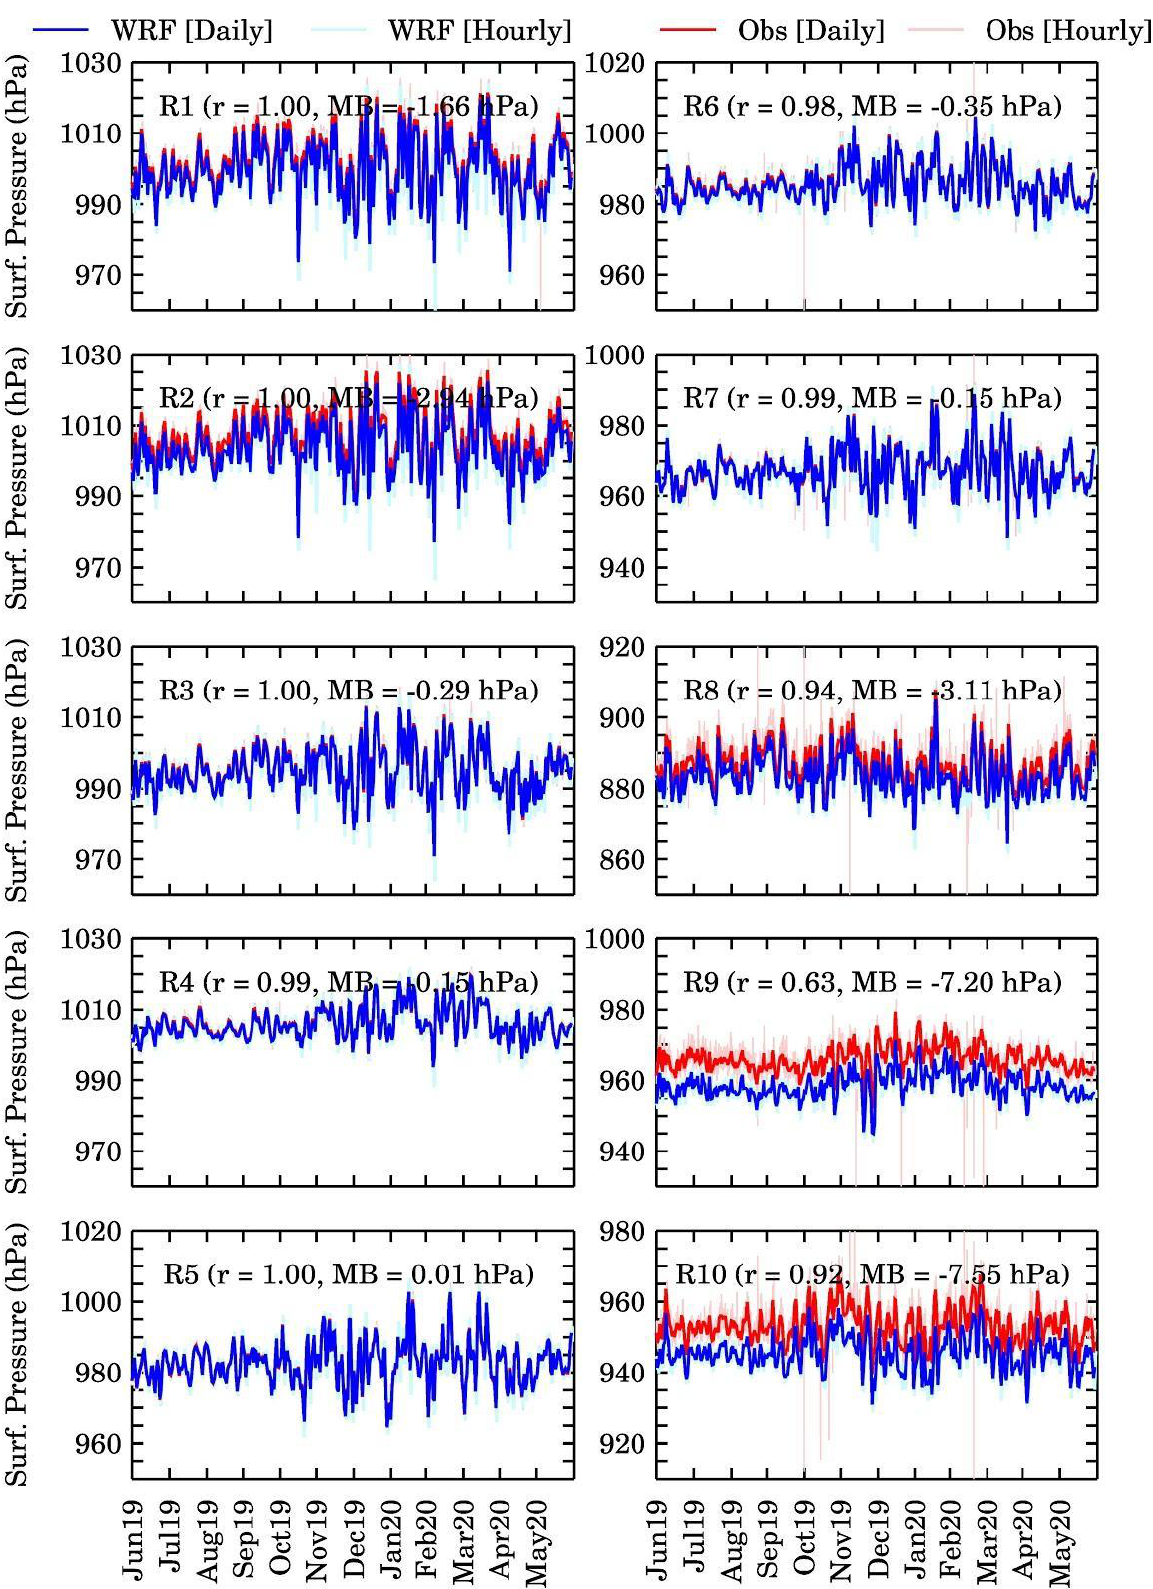
Figure 5. Seasonal variations in hourly and daily observed and model-simulated surface pressure in 10 EPA regions during June 2019 to May 2020. r and MB for each region estimated using paired data for the full year are also shown.